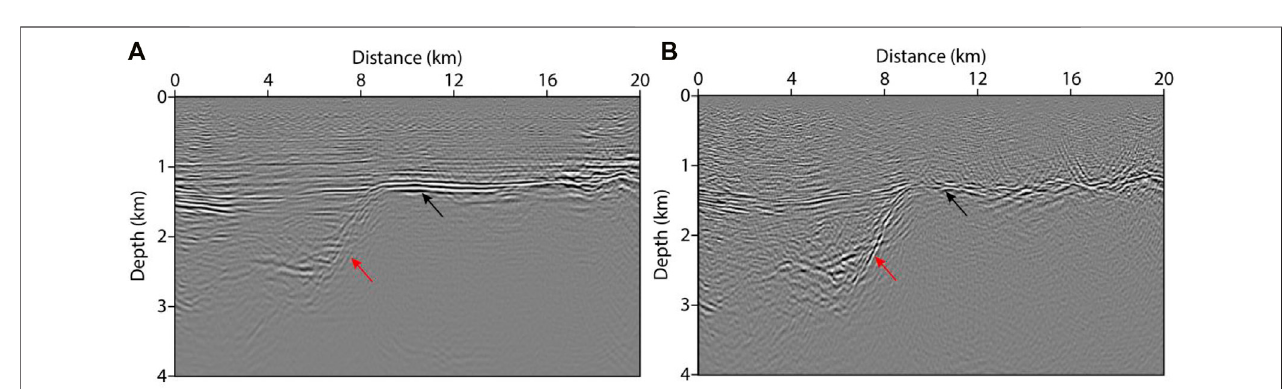
FIGURE 20 | Migration images after 5 iterations using AS-F-LSRTM (A) and AS-D-LSRTM (B) .